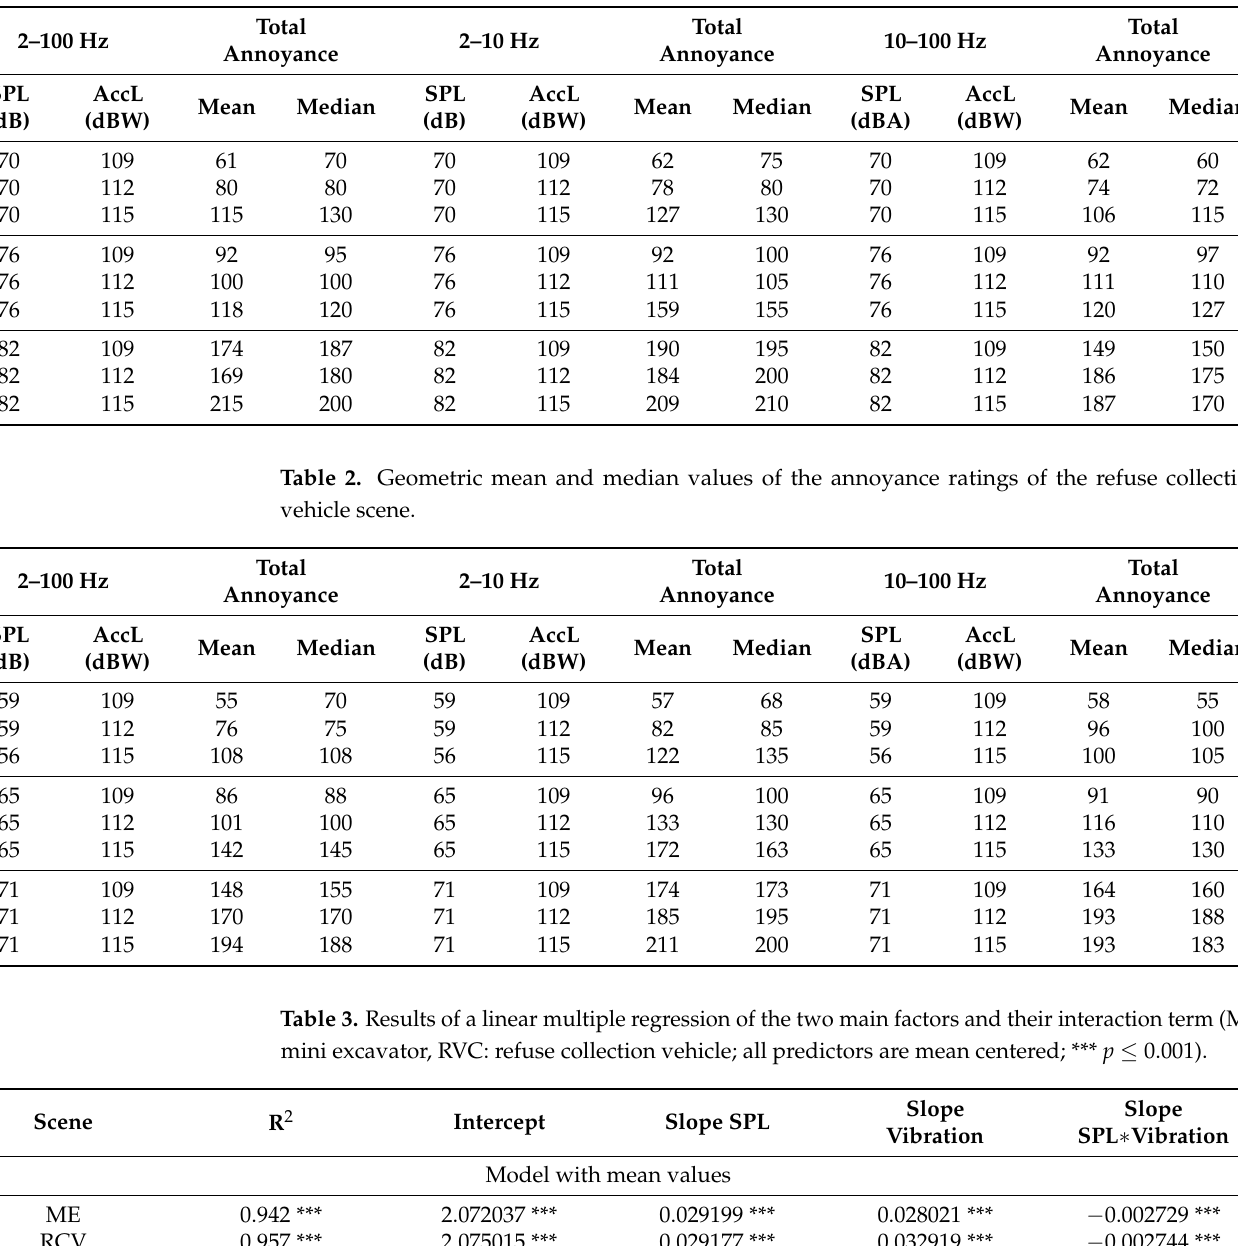
Table 1. Geometric mean and median values of the annoyance ratings of the mini excavator scene.